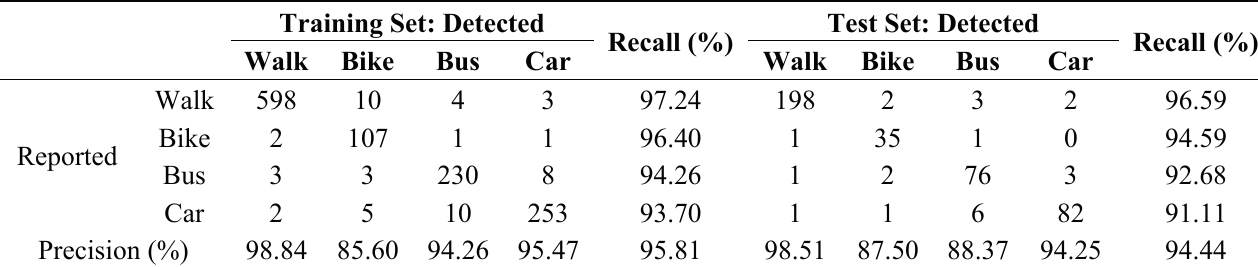
Table 2. Confusion matrix of the neural network.